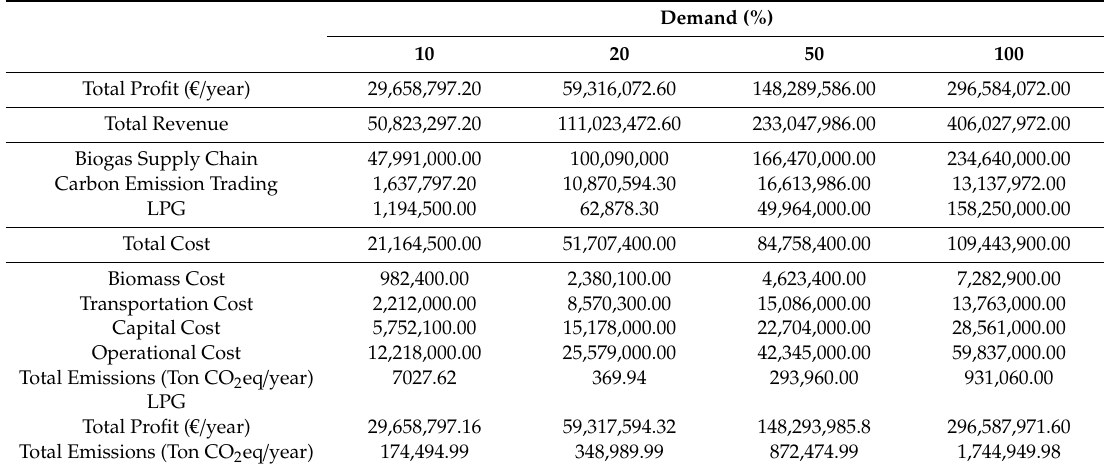
Table 3. Broken-down results for multi-objective